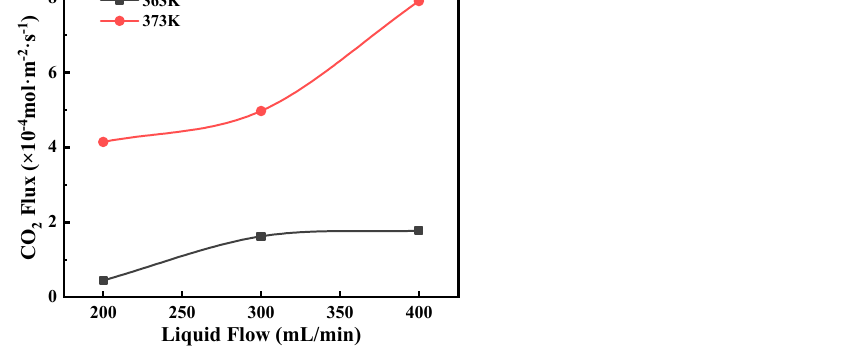
Figure 10. The effect of feed flow rate on CO 2 flux at different temperatures. Experimental conditions: P = 60 kPa, C MEA = 5.0 mol/L, CO 2 loading = 0.45 mol CO 2 /mol MEA.